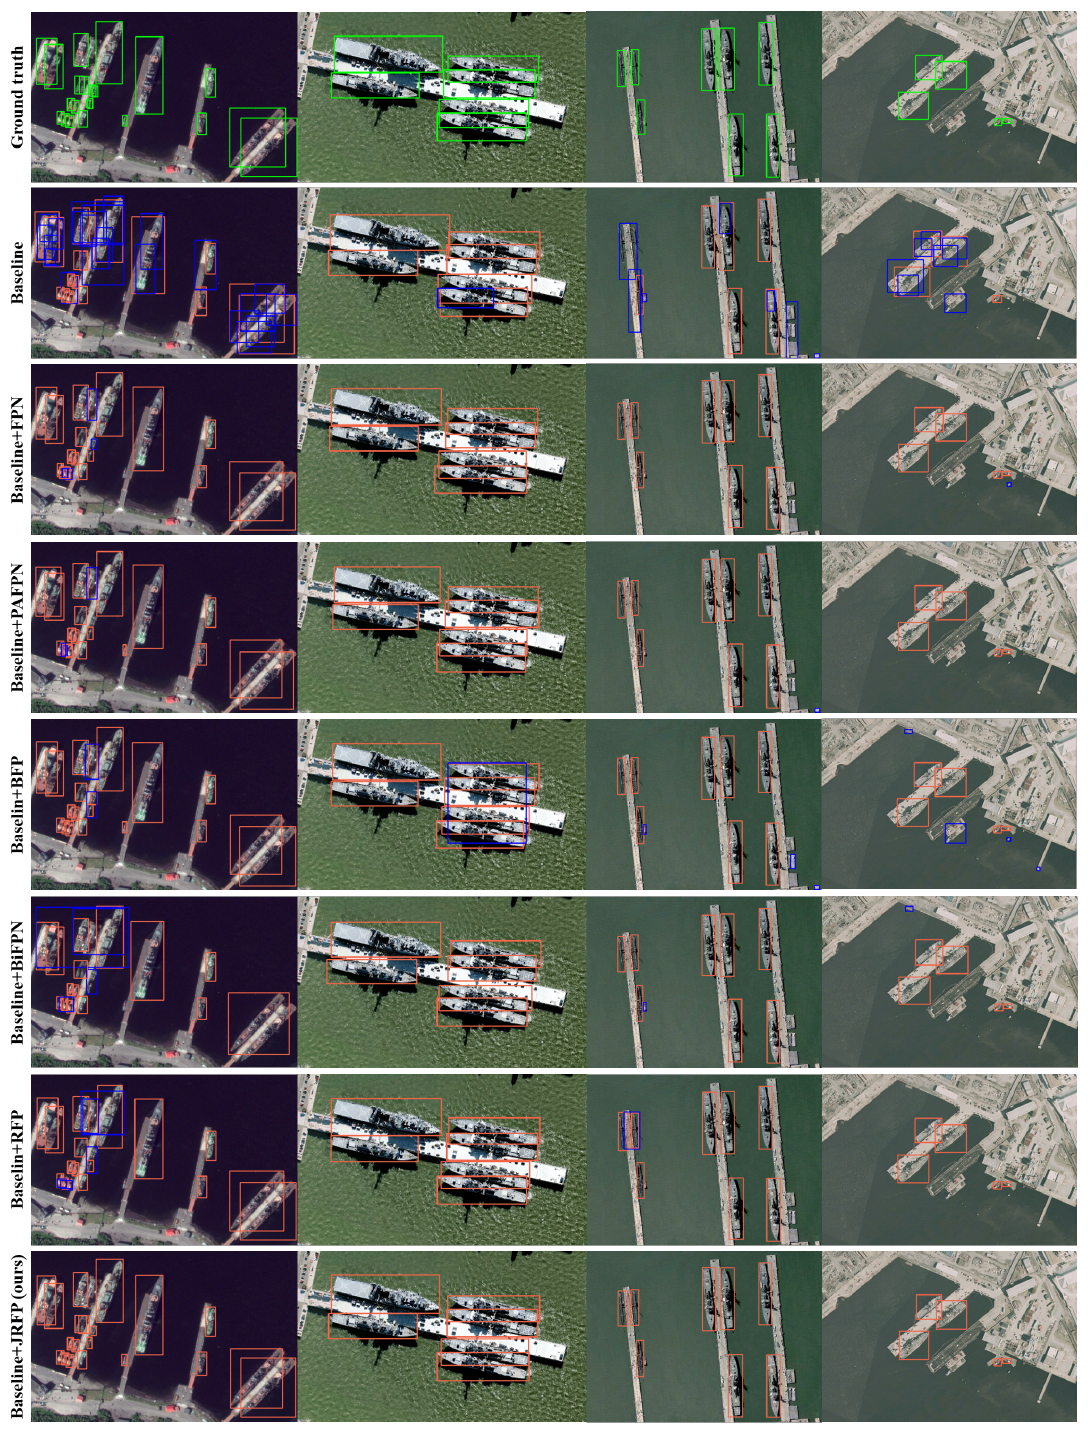
Figure 7. Visual results of hierarchical pyramid structure ablation study on HRSC2016-MS dataset. Bounding boxes with green , orange , and blue colors represent ground truths, true positive predic- tions, and false alarms,